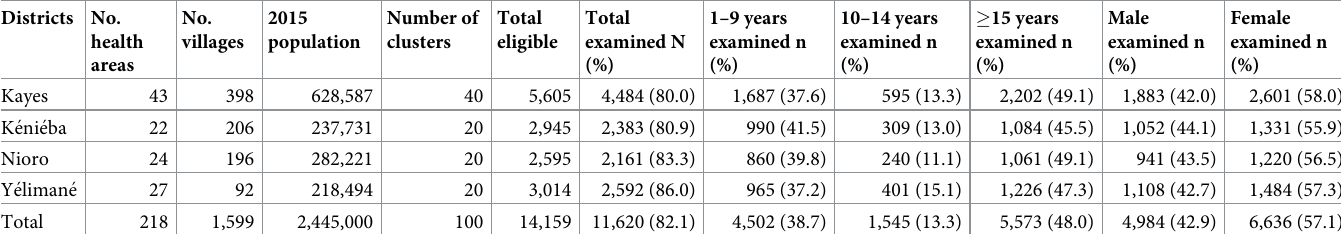
Table 1. Demographic information (2015), clusters and number of persons examined in each district. Districts No. health